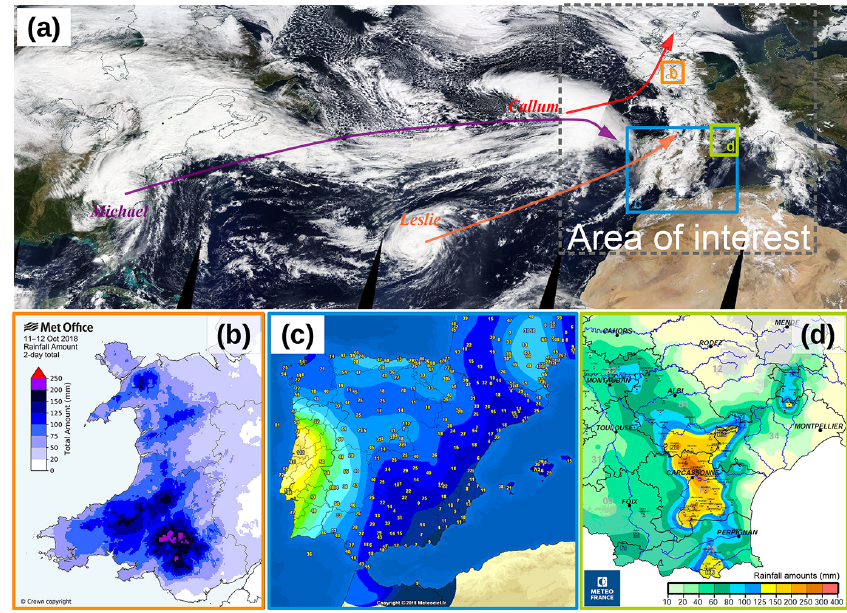
Figure 2. Illustrations of the case study. (a) True colour image of Terra/MODIS (source: https://worldview.earthdata.nasa.gov/, last access: 7 April 2022) on 11 October 2018 over the North Atlantic Ocean showing the storm Callum and the hurricanes Leslie and Michael (arrows de- pict their trajectories towards the area of interest); (b) rainfall totals (mm) from 11 to 12 October 2018 over Wales (Callum’s impacts, Fig. 64 from Kendon et al., 2019, source: MetOffice); (c) wind gust observations (kmh − 1 ) over the Iberian Peninsula on 13 October 2018 around 23:00UTC (Leslie’s landfall, source: https://www.meteociel.fr/, last access: 7 April 2022); (d) rainfall amounts (mm) between 06:00UTC on 14 October and 06:00UTC on 15 October 2018 over the French Languedoc region (Aude event, source: Météo-France – edited 19 Febru- ary